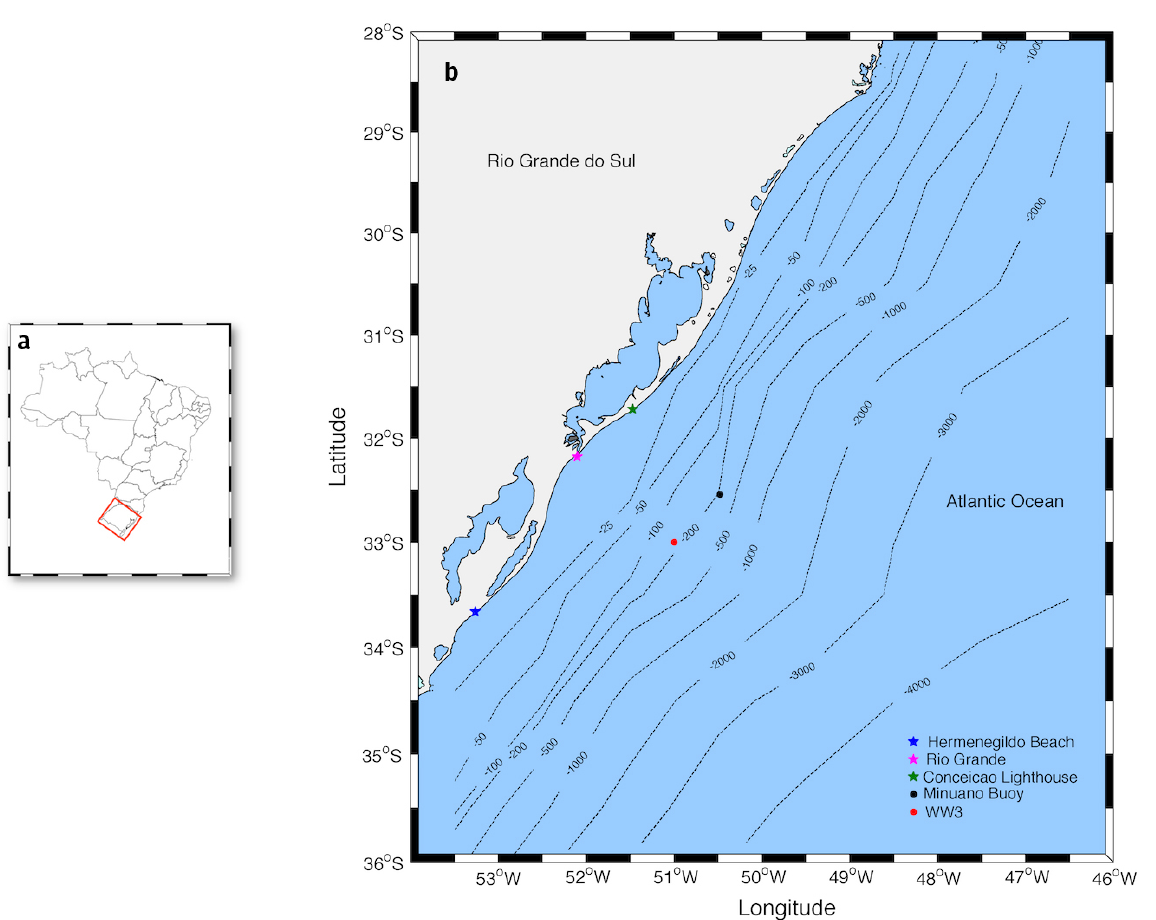
Figure 1. Study area representation. (a) Brazil map highlights (red) the Rio Grande do Sul coastline. (b) Rio Grande do Sul coastline with bathymetry isolines in dashed lines. The blue, pink and green stars represent Hermenegildo Beach, Rio Grande City and Conceição lighthouse, respectively. The black point indicates the Minuano buoy and the red point represents the WW3 grid